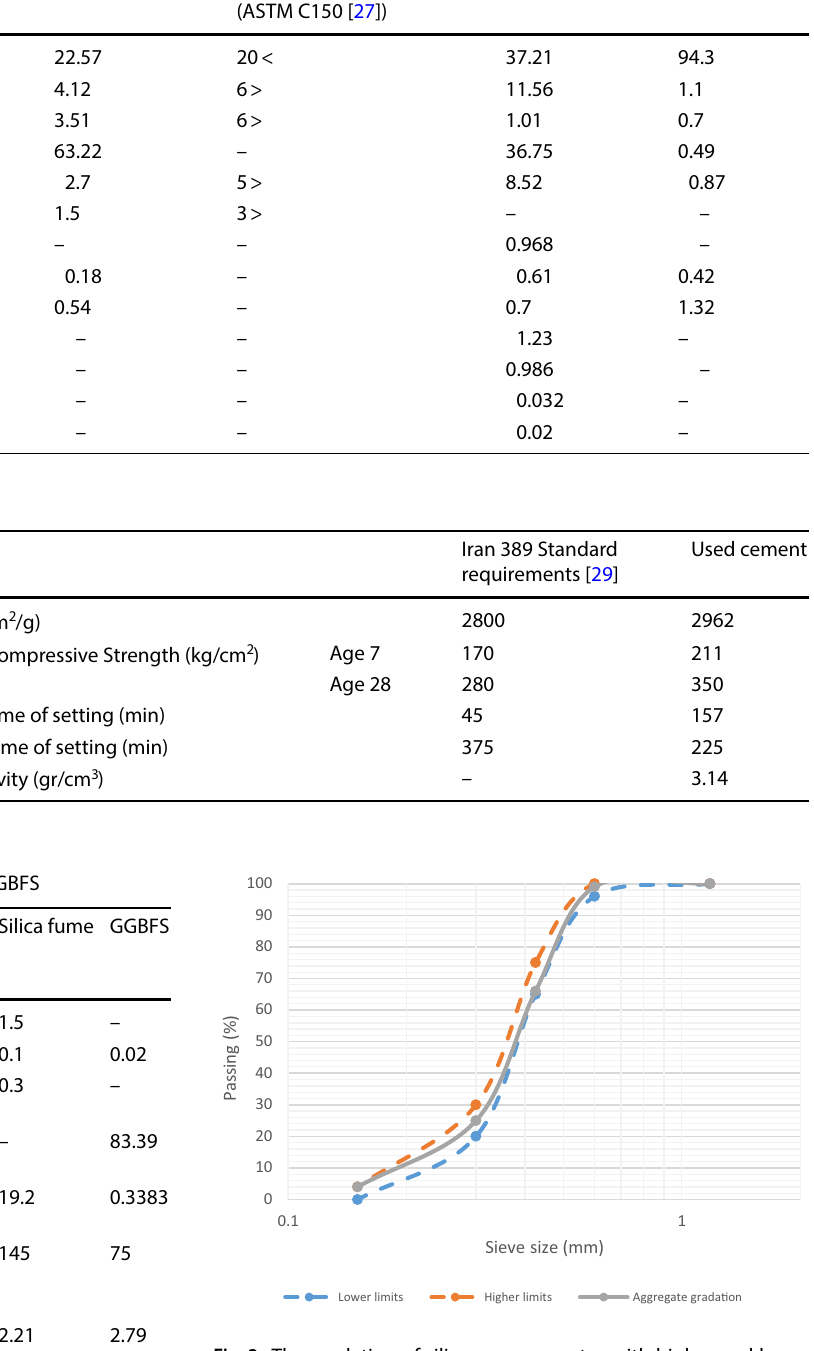
Table 2 Chemical characteristics and standard values of binders